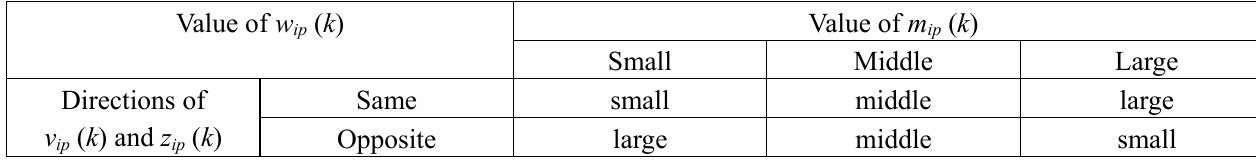
Table 1. Adaptive inertia weight strategy.